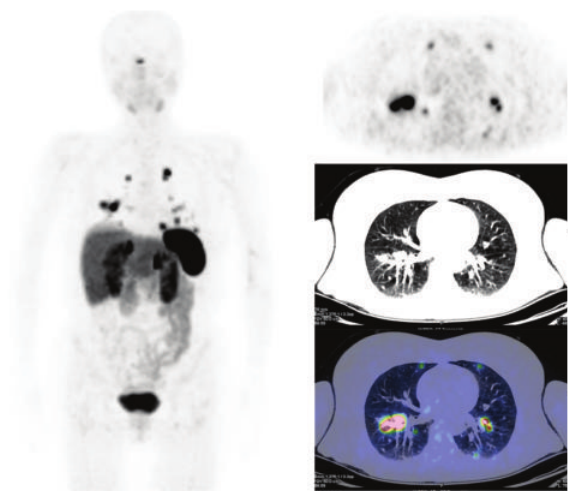
Figure 7: 68 Ga-DOTATATE PET/CT images (MIP, axial) in a patient with metastatic iodine-negative differentiated thyroid carcinoma.